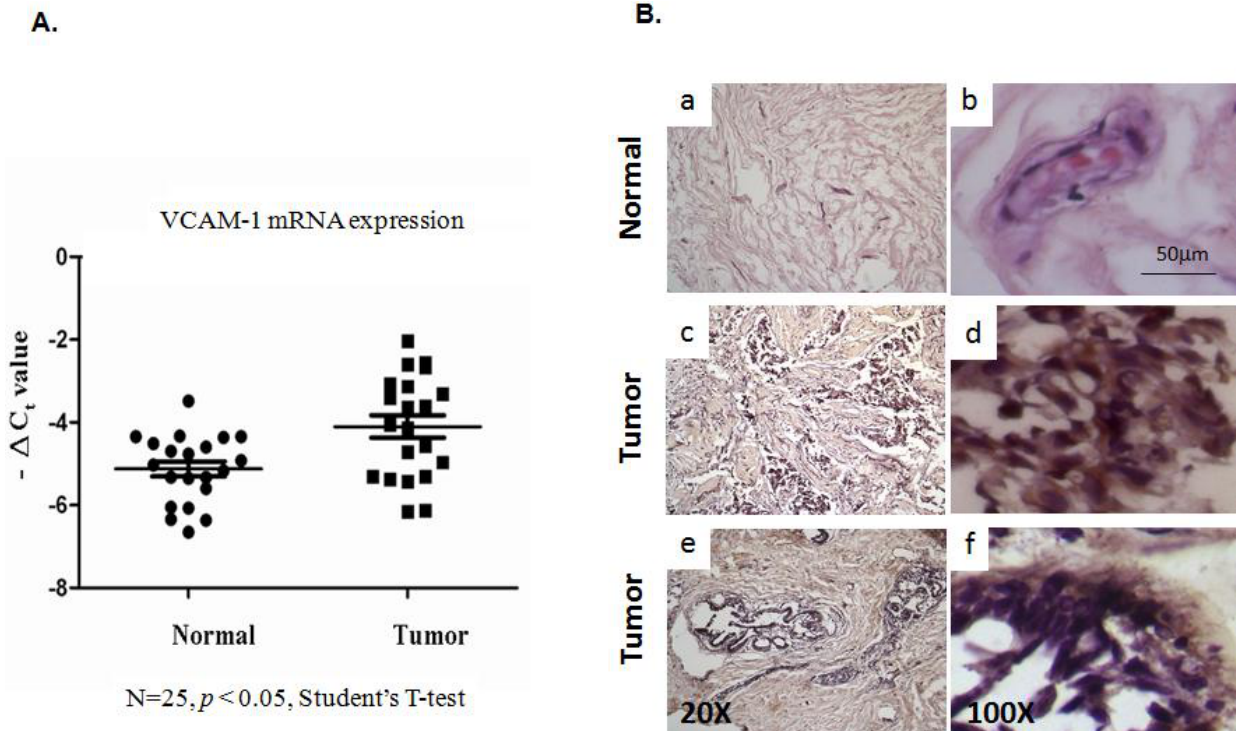
Figure 1. ( A ) RT-qPCR analysis of VCAM-1 expression in breast tumor tissues (tumor stage 1 + 2 AB and 3) and noncancerous controls; ( B ) a , b , Representative IHC staining of VCAM-1 in normal breast tissues; c – f , VCAM-1 expression in human breast tumor tissues. The magnifications are